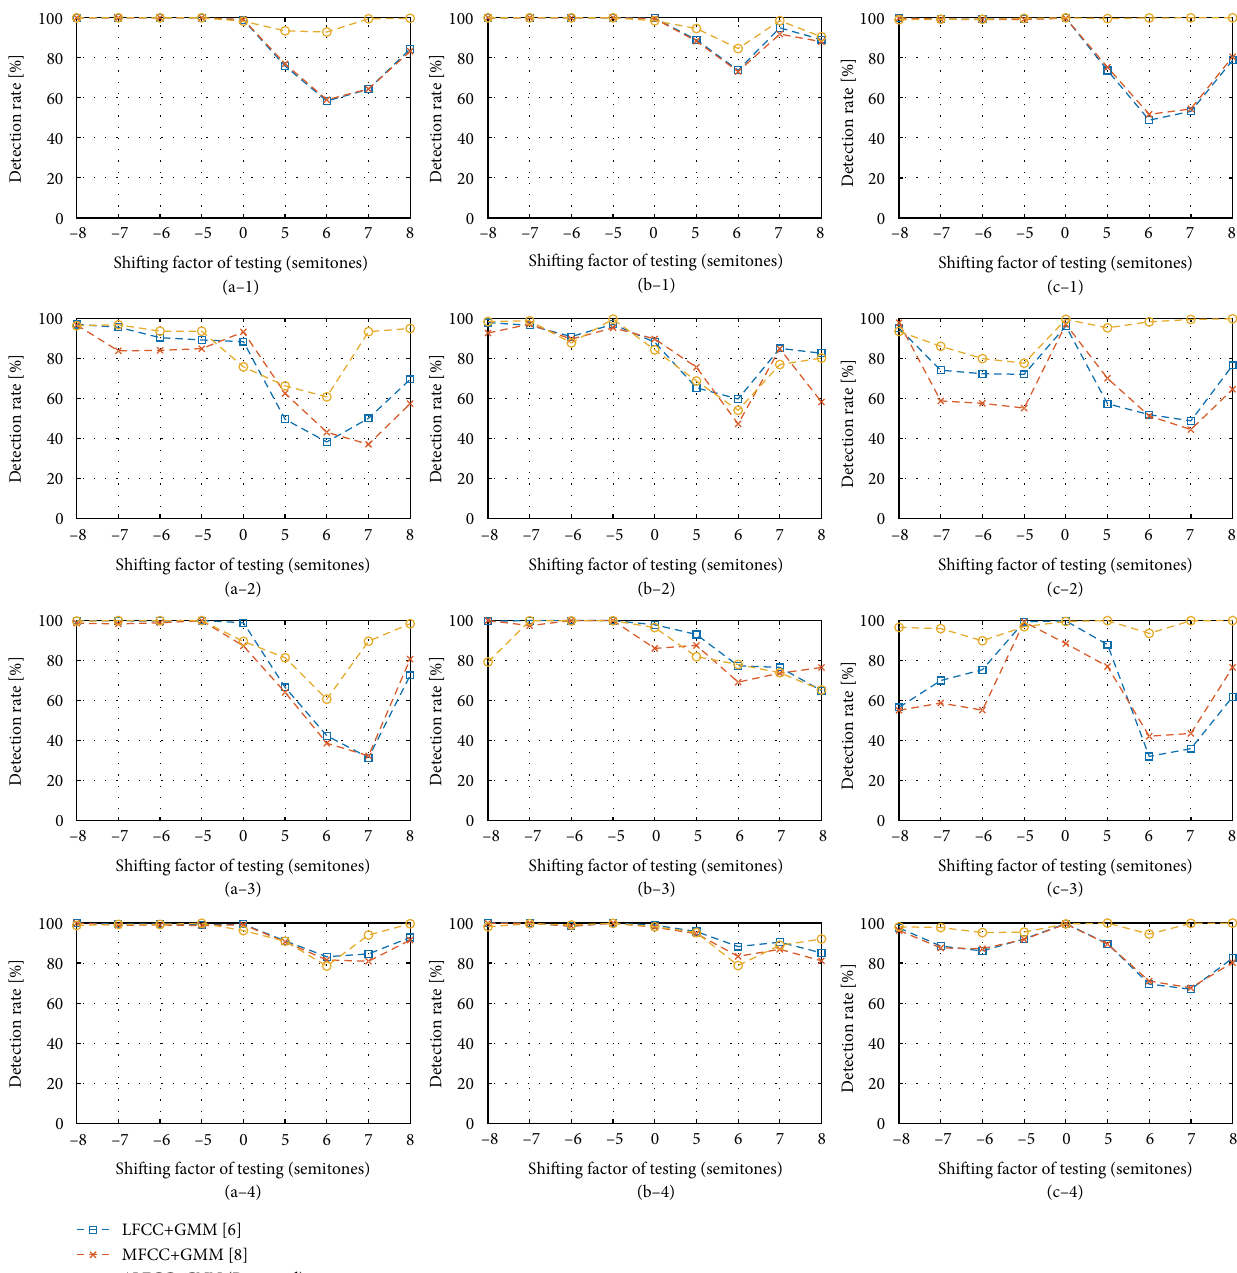
Figure 6: Detection rates of strongly pitch-shifted voice. (a- x ) Voice pitch-shifted by Audition. (b- x ) Voice pitch-shifted by GoldWave. (c- x ) Voice pitch-shifted by Audacity; x represents subfigures in same column . ( y -1) TIMIT for training and TIMIT for testing. ( y -2) TIMIT for training and UME for testing. ( y -3) UME for training and TIMIT for testing. ( y -4) UME for training and UME for testing; y represents subfigures in same